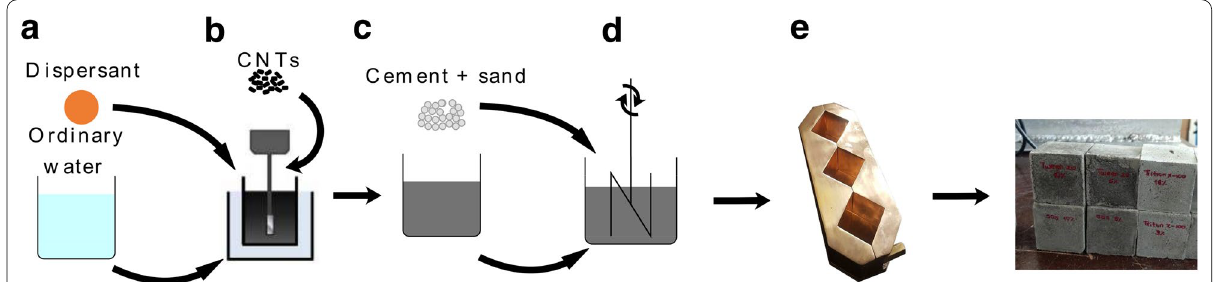
Fig. 1 Manufacturing process of the CBM/CNT